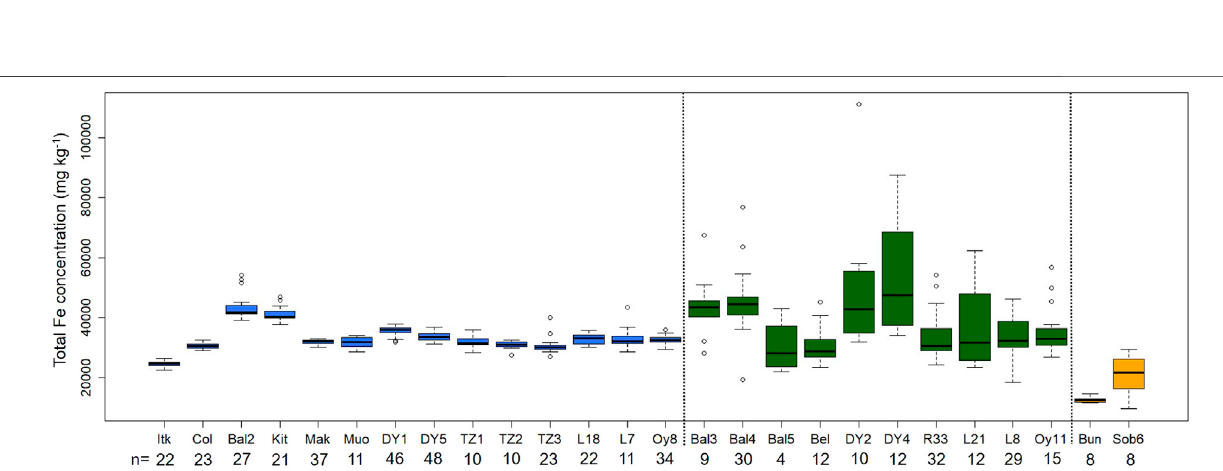
Frontiers in Earth Science |